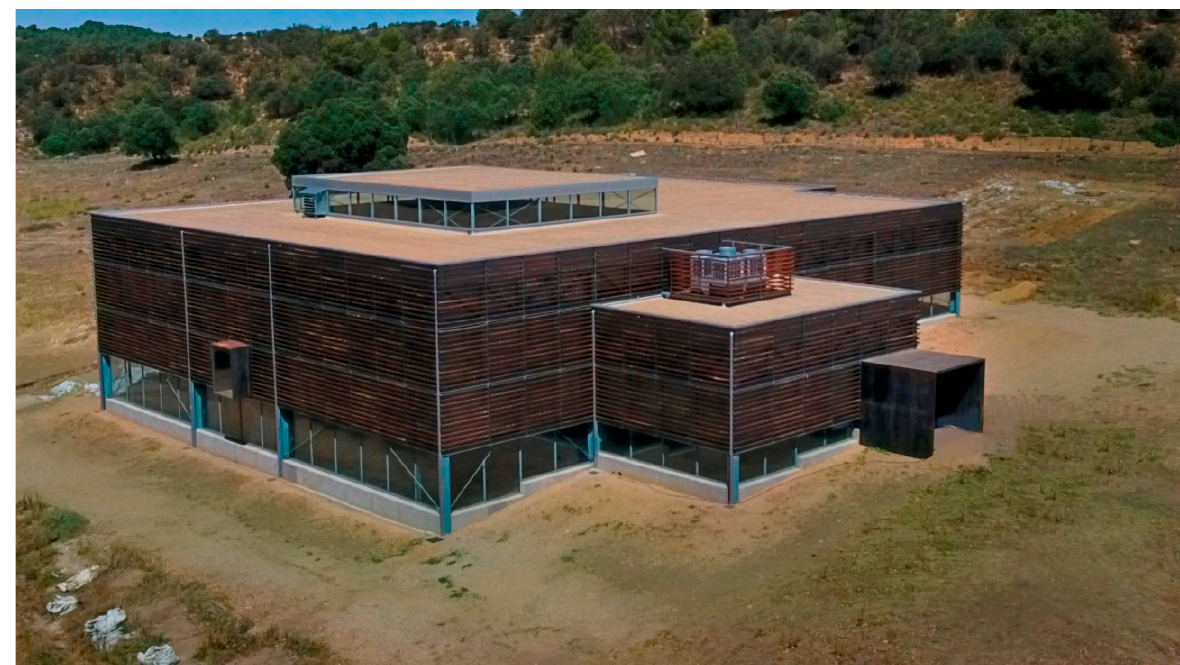
Figure 2. Aerial view of the building constructed at Noheda to protect and exhibit the mosaics. Photo: Antonio Gálvez.